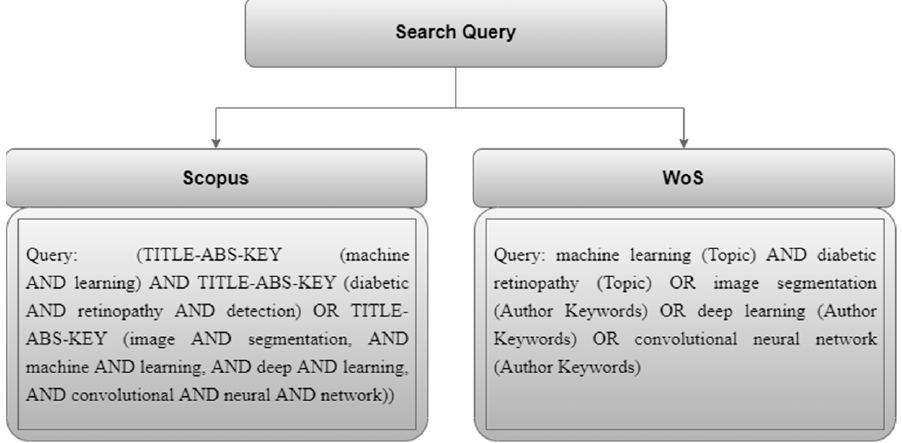
Figure 5. Search queries.